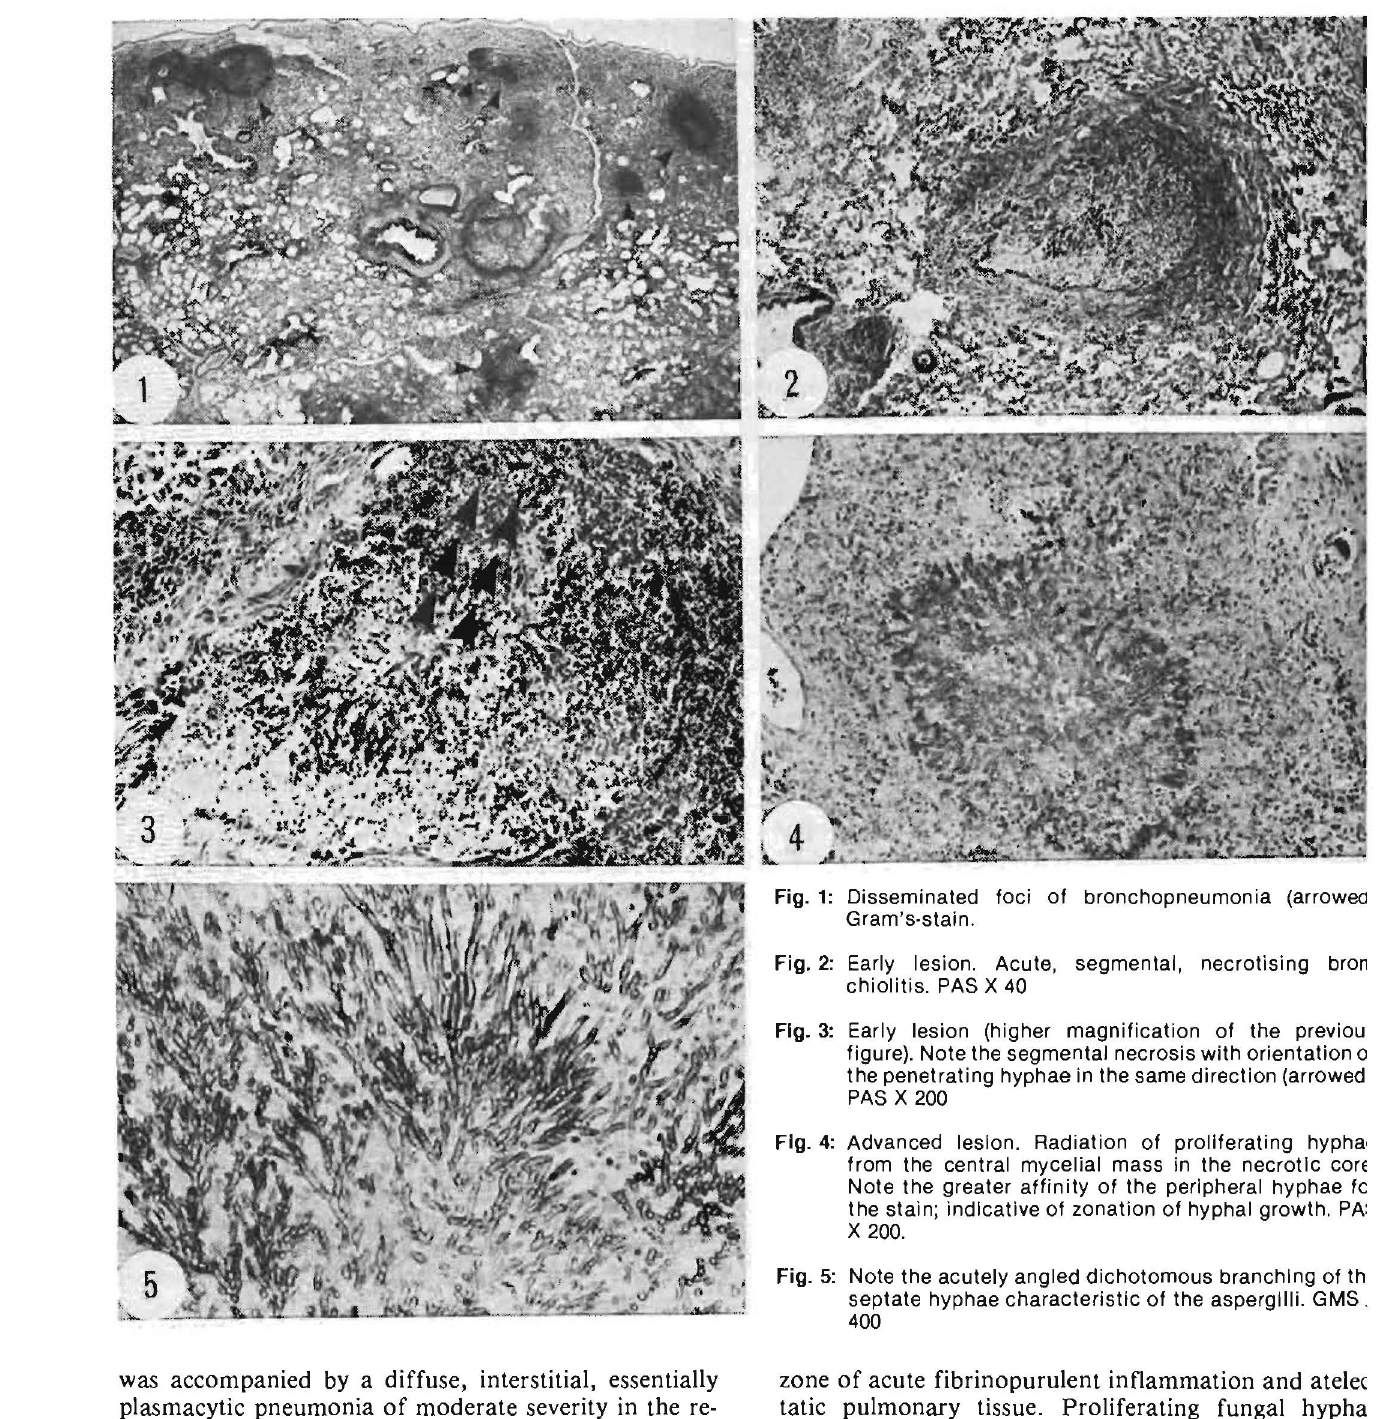
Disseminated foci of bronchopneumonia (arrowea Gram's·stain. Fig. 2: Early lesion. Acute, segmental, necrotising bron chiolitis. PAS X 40 Fig. 3: Early lesion (higher magnification of the previou figure). Note the segmental necrosis with orientation 0 the penetrating hyphae in the same direction (arrowed PAS X 200 Fig. 4: Advanced lesion. Radiation of proliferating hypha, from the central mycelial mass in the necrotic corE Note the greater affinity of the peripheral hyphae fe the stain; indicative of zonation of hyphal growth. PA: X 200. Fig. 5: Note the acutely angled dichotomous branching of th septate hyphae characteristic of the aspergilli. GMS.